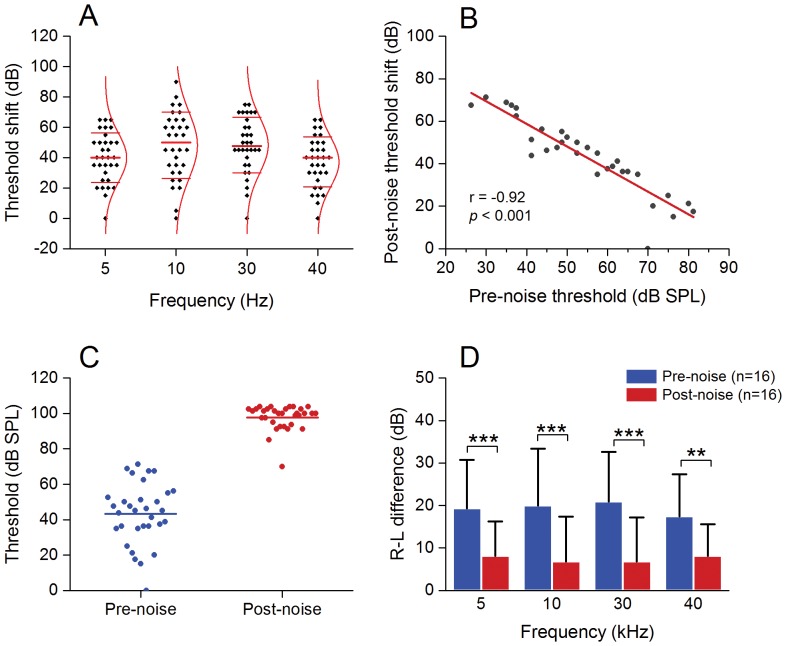
The level of noise-induced ABR threshold shifts is correlated with the level of pre-noise cochlear dysfunction in Prestin-CreERT2 homozygous mice.
A A scatter plot shows significant individual variation in the levels of the threshold shifts of ABRs examined at 2 h post-noise exposure in the ears of Prestin-CreERT2 homozygous mice. The three horizontal lines in each frequency indicate the mean and ± standard deviation. The curve line represents the distribution curve of the data. One dot represents the averaged threshold of one ear from the thresholds of the four tested frequencies (5, 10, 30 and 40 kHz). B Correlation between the average pre-noise thresholds and post-noise threshold shifts of ABRs in the Prestin-CreERT2 homozygous mice. There is a negative correlation between the two variables (Pearson's correlation analysis, r = −0.92, p<0.001), indicating that, with the increase in the level of pre-noise hearing dysfunction, the noise-induced threshold shift decreases. C Comparison of the magnitude of individual variation in ABR thresholds, measured before and after the acoustic overstimulation in the Prestin-CreERT2 homozygous mice. One dot represents the threshold of one ear, as averaged from the thresholds of the four tested frequencies. The horizontal lines represent the means of the average ABR thresholds. Notice that the level of individual variation became smaller after the noise exposure. D Comparison of the levels of the two-ear difference in the ABR thresholds examined before and after the acoustic overstimulation. The levels of difference are significantly reduced after the acoustic trauma (two-way ANOVA, F1, 120 = 41.47, P<0.001; *** indicates P<0.001 and ** indicates P<0.01 tested by Tukey test). n: the number of ears used for each condition.